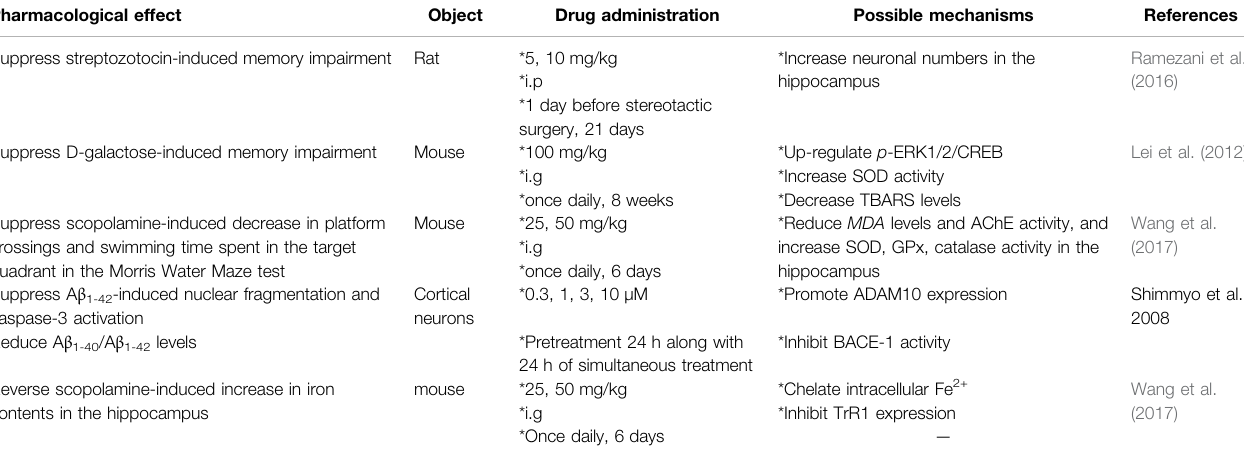
TABLE 2 | Comprehensive information about the effects of myricetin in animal models Alzheimer ’ s